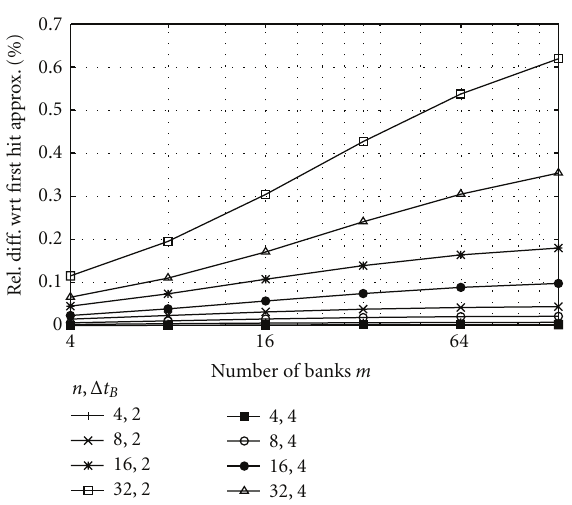
Figure 6: Accuracy of the single-hit approximation for n H ≥ 2.